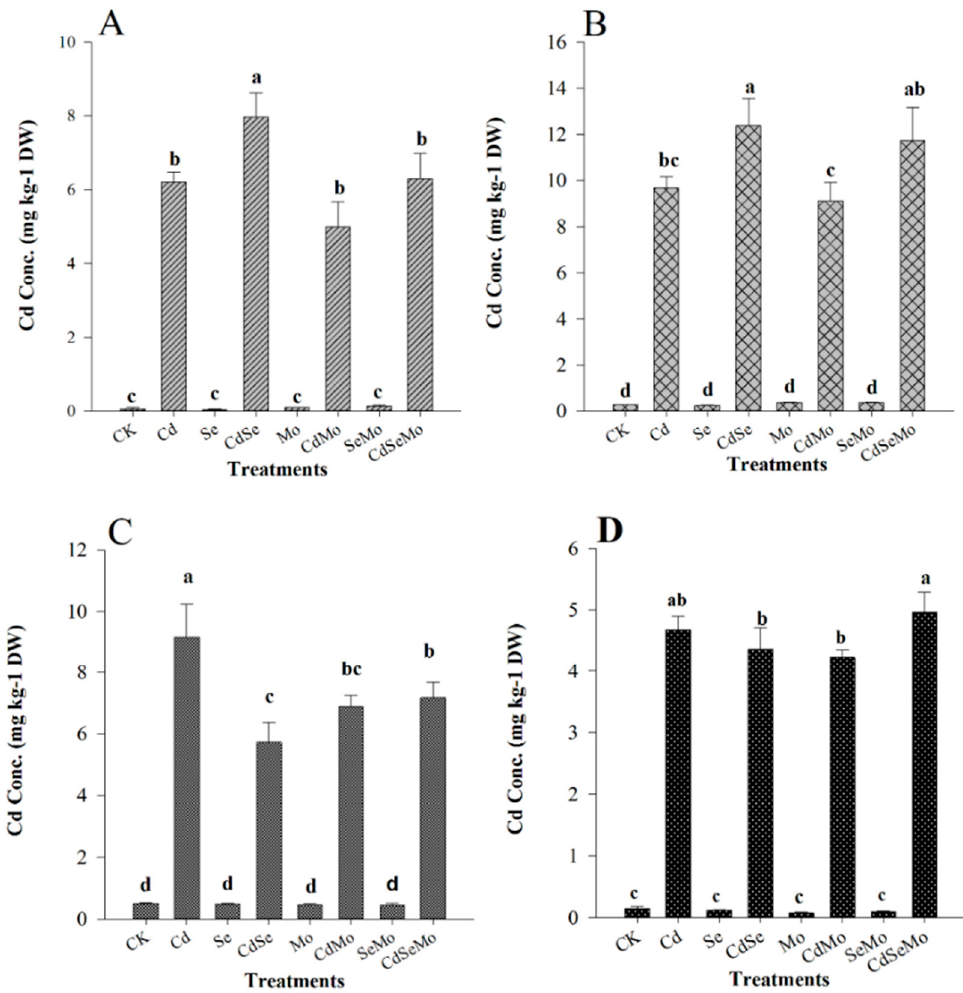
Figure 2. Concentrations of Cd in B. napus tissues. Cd concentration in root ( A ), stem ( B ), glume ( C ), and seed ( D ) of oilseed rape treated with foliar spray of (1 mg/L) Se and/or (0.3 mg/L) Mo in absence or presence of Cd stress (5 mg/kg). All data show the means ± SD of four replicates. Different letters within a column indicate significant ( p < 0.05) differences between treatments.